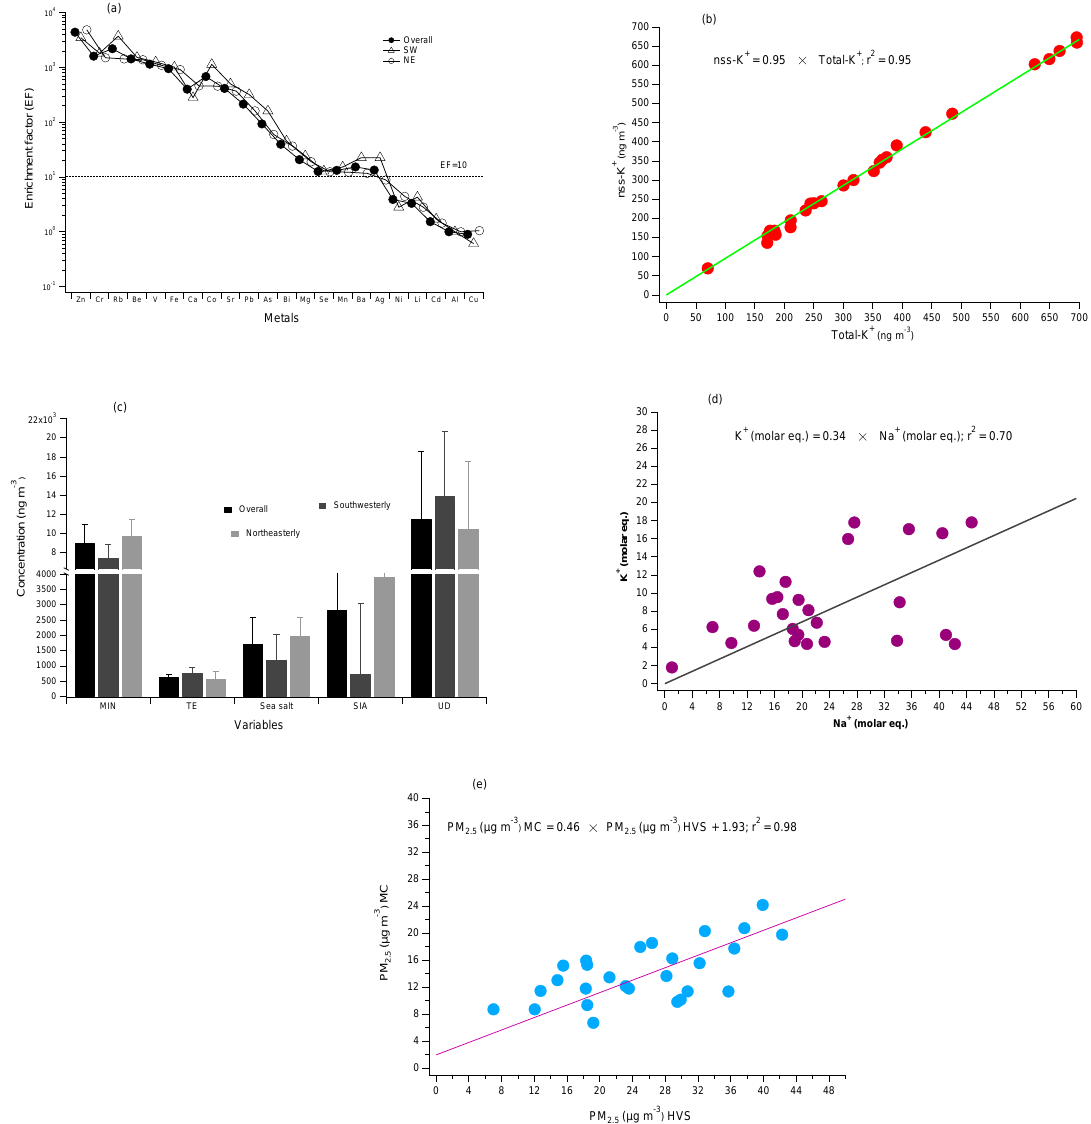
Figure 5. (a) Enrichment factor (EF) of heavy metals in PM 2 . 5 , (b) correlation plot of nss-K + and total K + , (c) reconstructed mass concen- tration of PM 2 . 5 by mass closure model, (d) correlation plot of K + and Na + , and (e) correlation plot of estimated PM 2 . 5 (MC) and measured PM 2 . 5